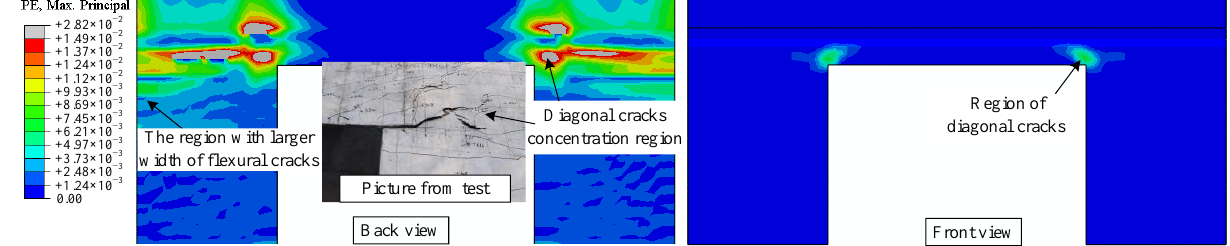
Figure 19. Maximum principal inelastic strain patterns from FE analysis.